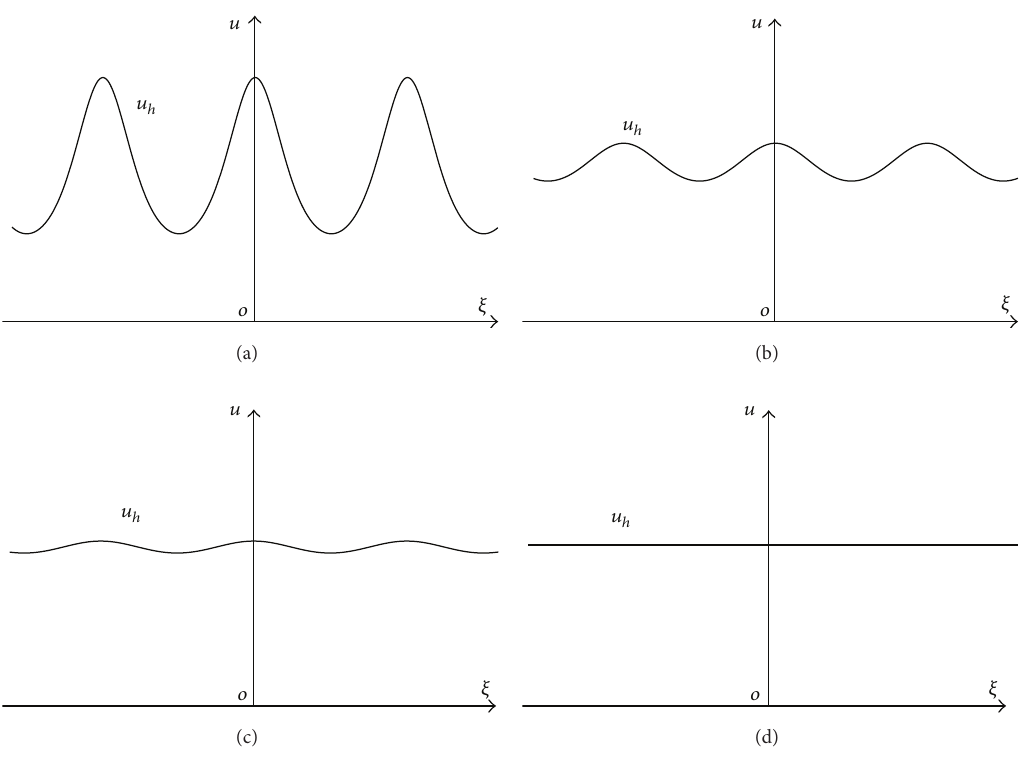
Figure 19: (The periodic wave become the trivial wave). The varying process for the graph of 𝑢 ℎ when 𝑐 > 0 , 𝛿 < 0 , 𝑎 > 0 , 𝜂 < 0 , and 𝑏 → −16𝑎 2 /75𝑐 + 0 , where 𝑐 = 1 , 𝛿 = −1 , 𝑎 = 1 , 𝜂 = −4.7 , and (a) 𝑏 = −16𝑎 2 /75𝑐 + 10 −2 . (b) 𝑏 = −16𝑎 2 /75𝑐 + 10 −3 . (c) 𝑏 = −16𝑎 2 /75𝑐 + 10 −4 . (d) 𝑏 = −16𝑎 2 /75𝑐 + 10 −7